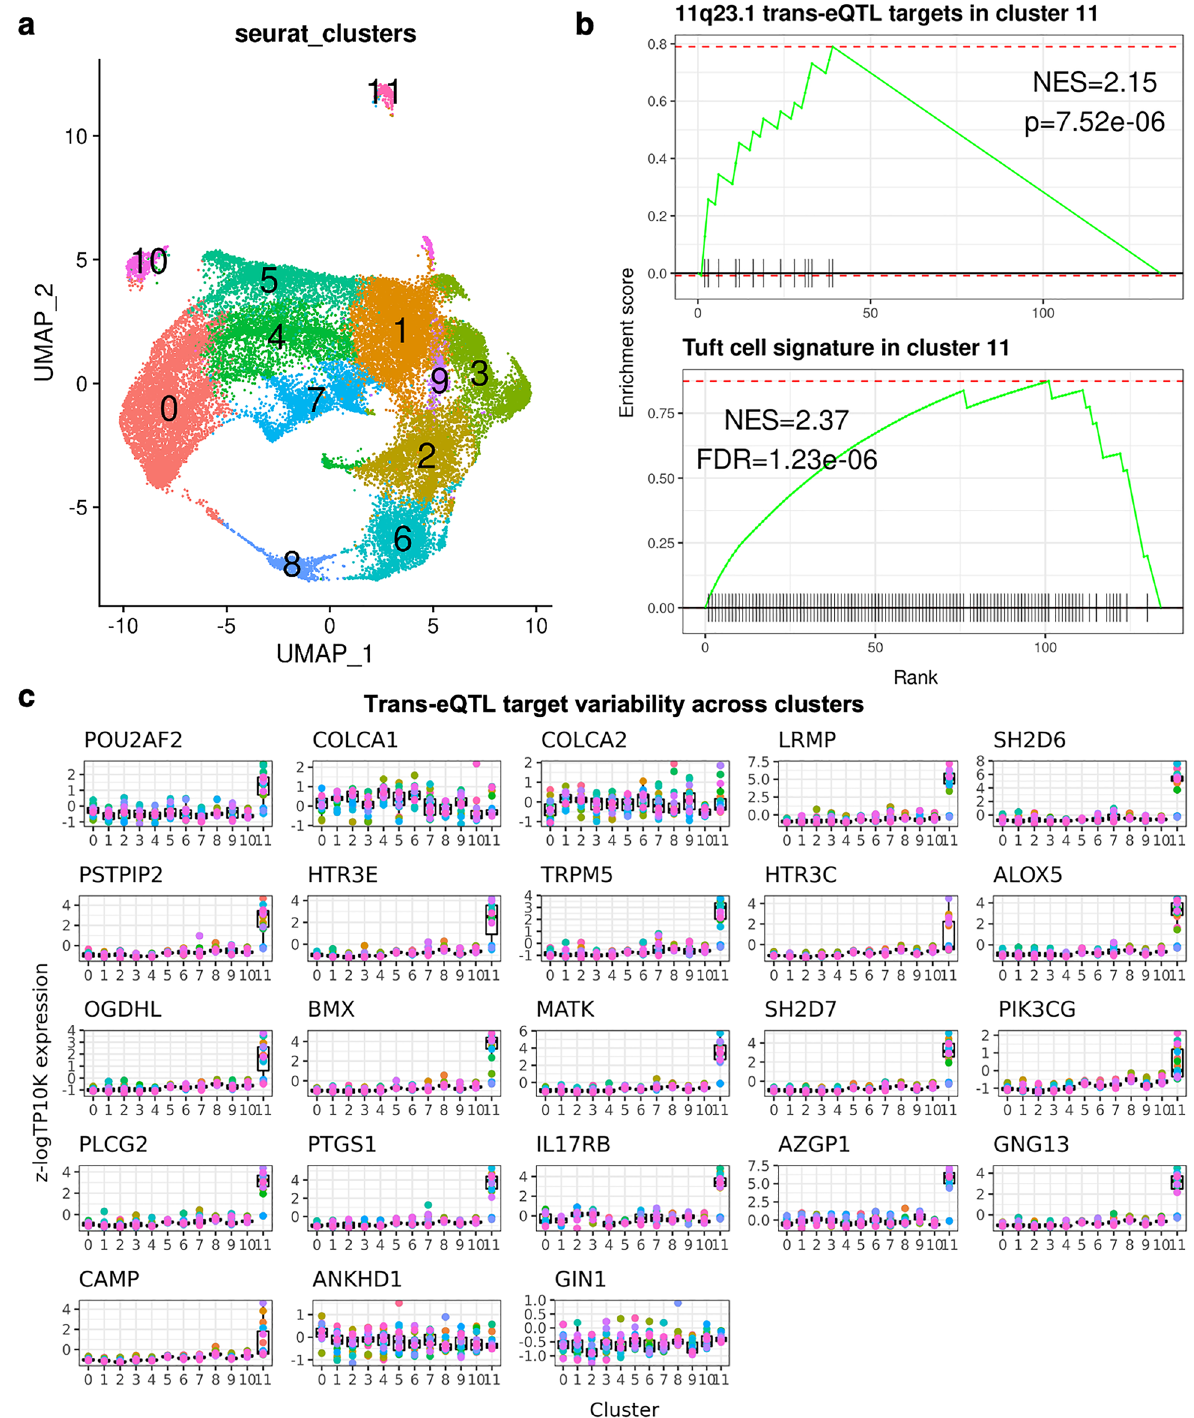
Figure 3. 11q23.1 trans-eQTL expression demarcates tuft-like cell cluster. ( a ) UMAP of 32,361 epithelial scRNASeq, coloured by cell cluster—identified using Seurat 42 . ( b ) Upper: GSEA of 11q23.1 trans-eQTL targets 11 ; FDR < 0.05) in cluster 11 markers. Lower: GSEA of putative colonic tuft cell signature 22 in cluster 11 markers. p p value, FDR false discovery rate. ( c ) Relative, pseudo-bulked expression (log transcripts per 10,000) of 11q23.1 trans-eQTL targets (FDR < 0.05) across